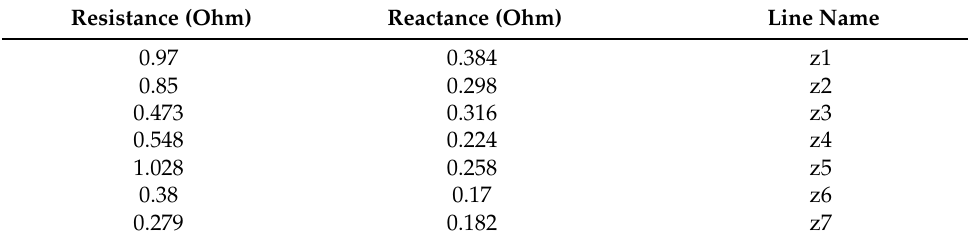
Table 2. Line parameters